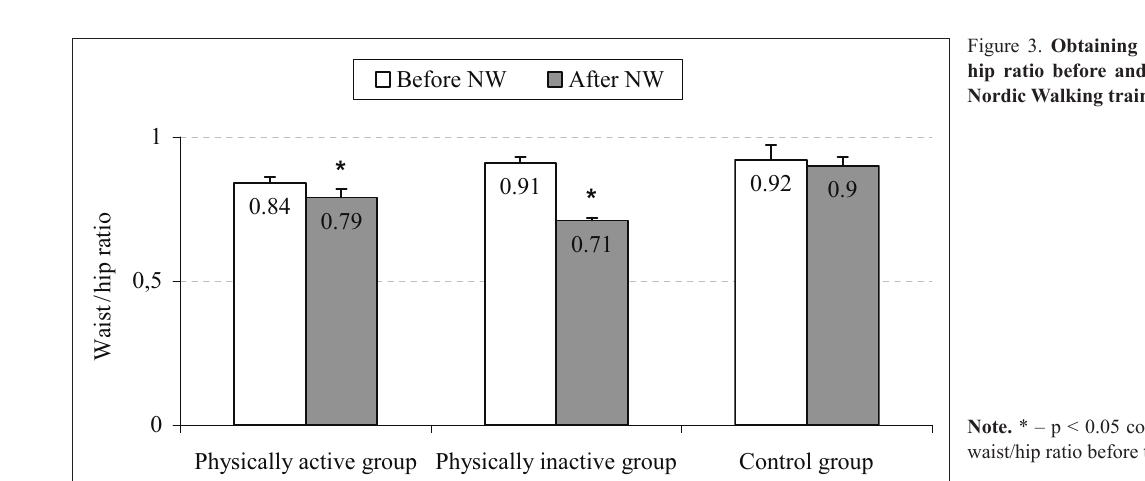
Note.* – p < 0.05 compared to the body weight before the NW.